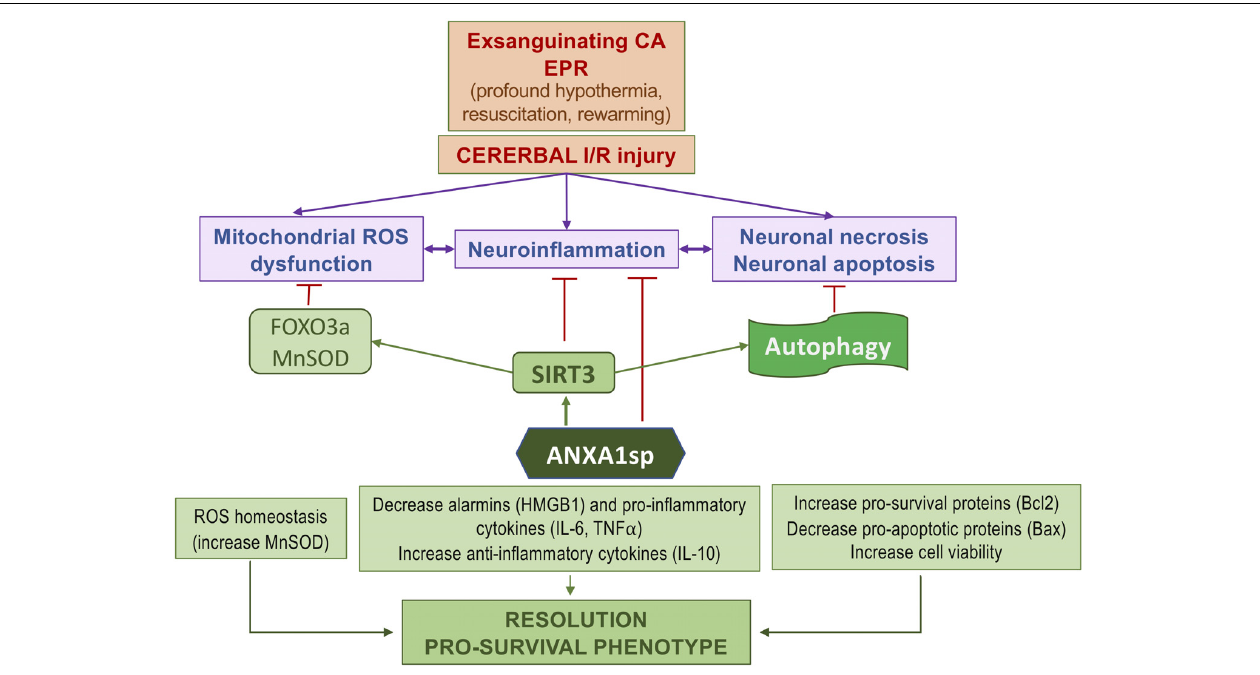
FIGURE 8 | Simplified diagram of the protective effects of ANXA1sp following cerebral ischemia-reperfusion injury associated with experimental exsanguinating cardiac arrest (CA) and emergent preservation and resuscitation